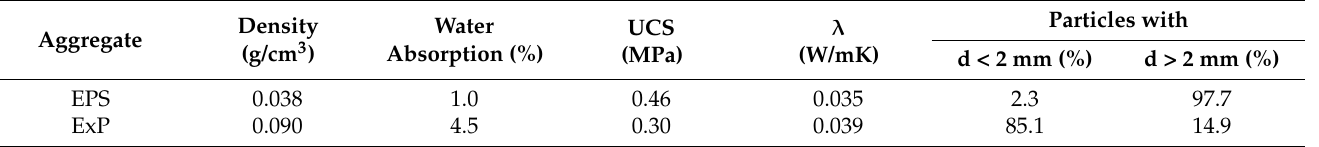
Table 2. Properties of EPS and